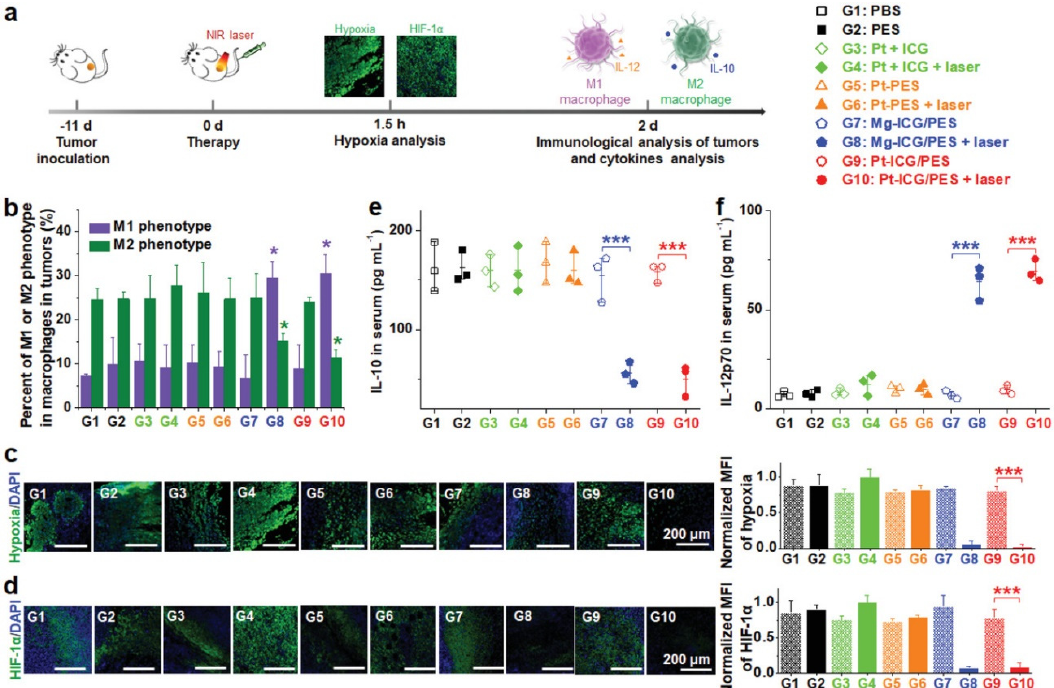
Figure 3. Hypoxia relief triggered by ICG-incorporating polymeric nanostructures when exposed to NIR light. ( a ) Schematic representation of the therapeutic procedure; ( b ) Macrophage phenotype in the tumor after the different treatments; Characterization of the ( c ) hypoxia and ( d ) hypoxia-inducible factor 1- α (HIF-1 α ) in tumor slices; Levels of ( e ) IL-10 and ( f ) IL-12p70 in the serum of mice after different treatments. Reprinted with permission from [32]. Copyright 2021 Wiley. PBS: phosphate-buffered saline; PES: poly [2-(2-methoxyethoxy) ethyl methacrylate- co -PEG methyl ether methacrylate]- b - poly(sodium p -styrenesulfonate); Pt + ICG: Cisplatin and ICG; Pt-PES: Cisplatin-loaded PES nanopar- ticles; Mg-ICG/PES: Magnesium dichloride and ICG-loaded PES nanoparticles/ICG-incorporated polymeric nanostructures; Pt-ICG/PES: Cisplatin and ICG-loaded PES nanoparticles; Laser: NIR light exposure. * p < 0.05; *** p <